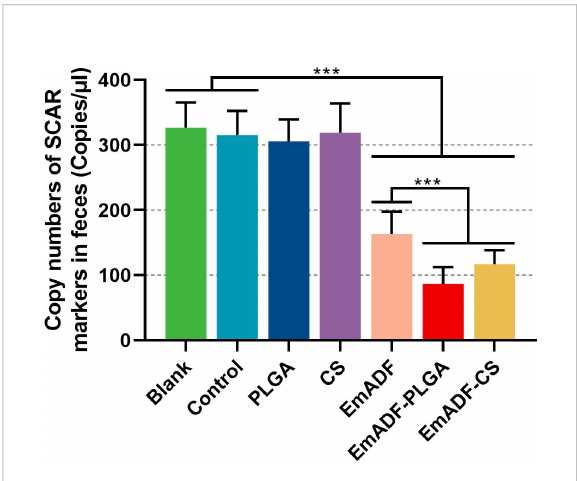
FIGURE 10 E. mitis oocyst burdens in the excreted feces from low-dose challenged chickens. Each chicken was orally challenged with 3,000 puri fi ed E. mitis oocysts seven days after the booster immunization. Seven days after challenge, feces of each chicken were collected for DNA extractions. Each group involved ten biological replicates, and each replication was detected three times. Values were estimated using one-way ANOVA analysis followed by Dunnett ’ s test. Comparisons among EmADF, EmADF-PLGA, and EmADF-CS group were conducted by ANOVA following Bonferroni ’ s correction. Values were presented as the mean of the mean ± SD. *** p<